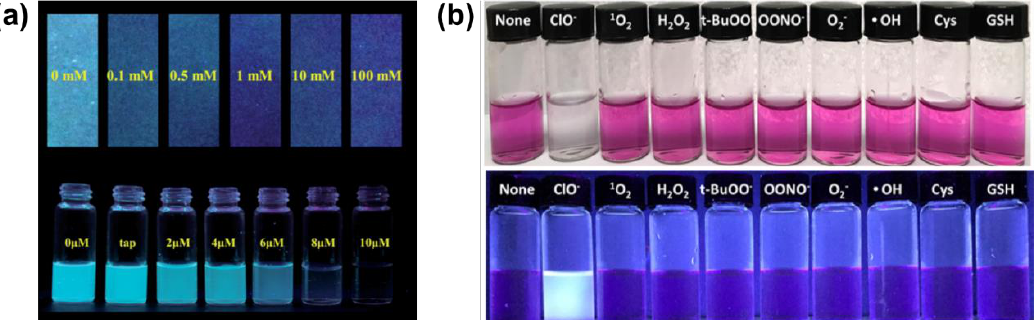
Figure 5. ( a ) Photos showing the emission-quenching of A16 in aqueous solutions and A16 -coated filter papers on exposure to water samples with an incremental amount of hypochlorite anions. Reproduced with permission from [60]. Copyright 2017, the Royal Society of Chemistry. ( b ) Photos showing the selective decolourisation and fluorescence turn-on of A18 in aqueous solution on exposure to hypochlorite. Reproduced with permission from [62]. Copyright 2019, Elsevier B. V.